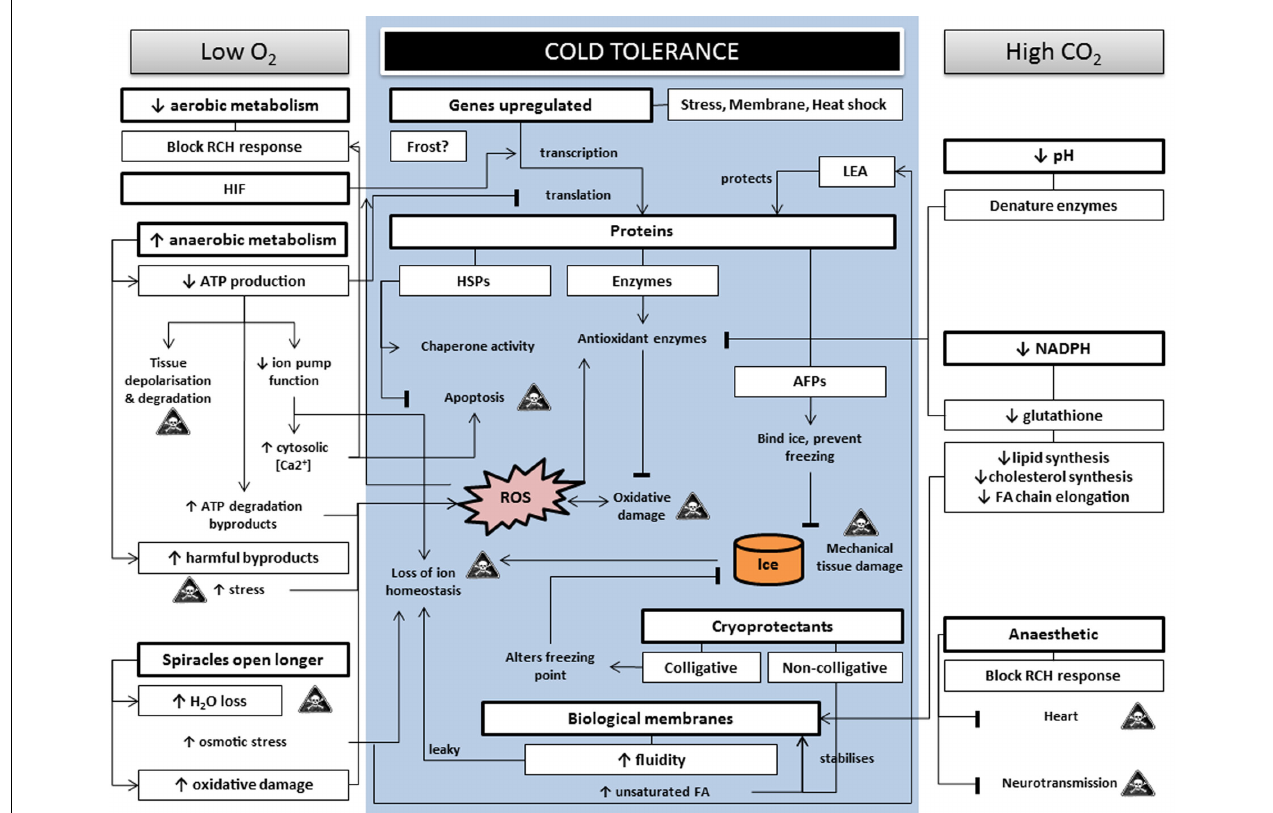
represents processes that are likely to lead to mortality. RCH, rapid cold hardening; ATP, adenosine triphosphate; HIF, hypoxia inducible factor; LEA, late embryogenesis abundant proteins; HSPs, heat shock proteins; AFPs, anti-freeze proteins; ROS, reactive oxygen species; FA, fatty acids; NADPH, reduced form of nicotinamide adenine dinucleotide